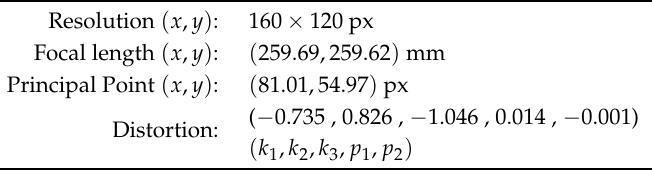
Table 4. Intrinsic parameters of the Hamamatsu pulse-based ToF prototype. The distortion is given using radial parameters ( k 1 ; k 2 ; k 3 ) and tangential parameters ( p 1 ; p 2 ) according to Zhang’s model